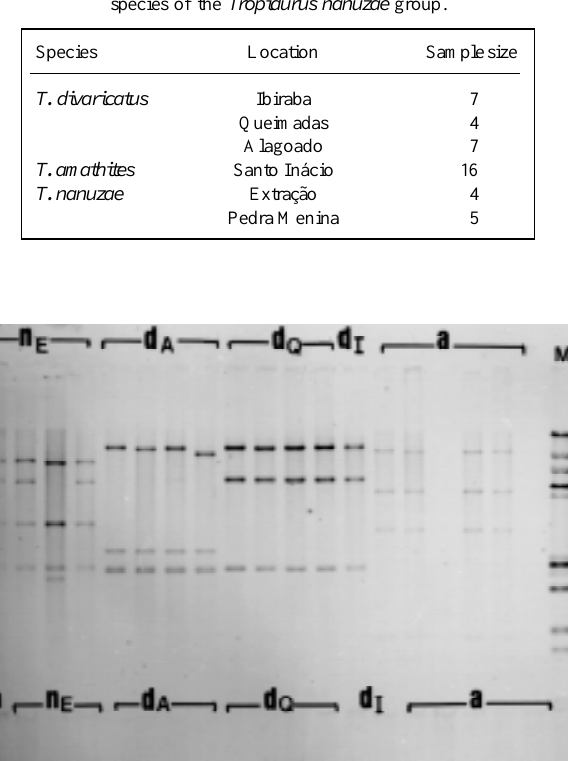
), Queimadas (d ) and Ibiraba (d ) and A Q I